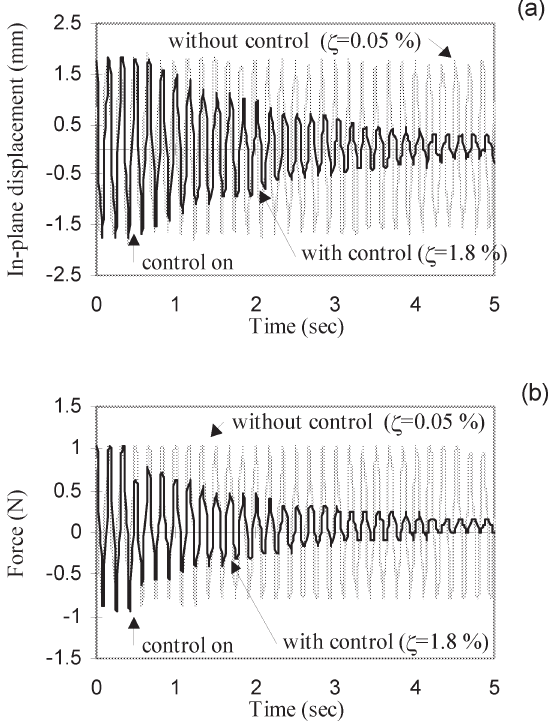
Fig. 11. Effect of the Integral Force Feedback on the free oscillations of the